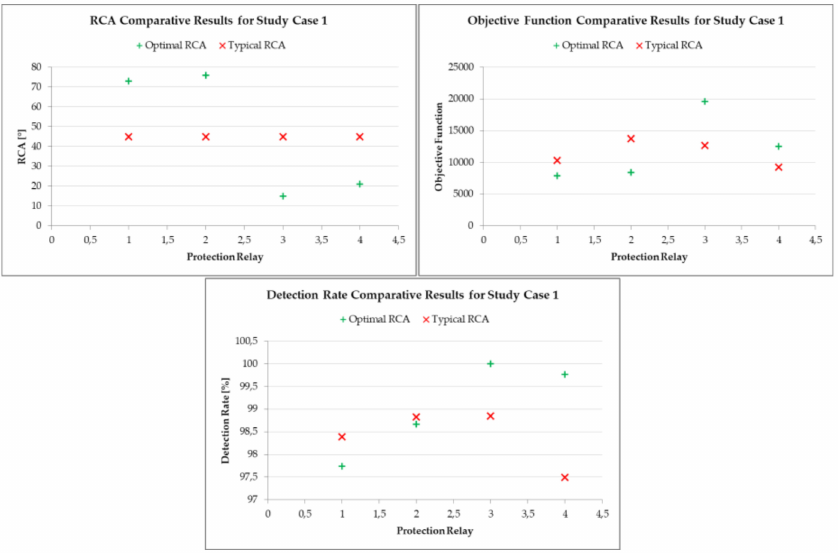
Figure 10. Comparative results for the evaluation of polarization on the directional phase overcurrent element (ANSI 67) in the protection relays of Study Case